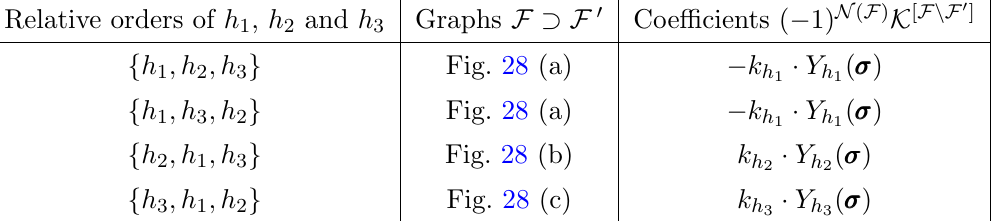
Figure 28 . All graphs F containing the skeleton F 0 = (cid:12)gure 6 (e). Relative orders of h , h and h Graphs F (cid:27) F 0 1 2 3